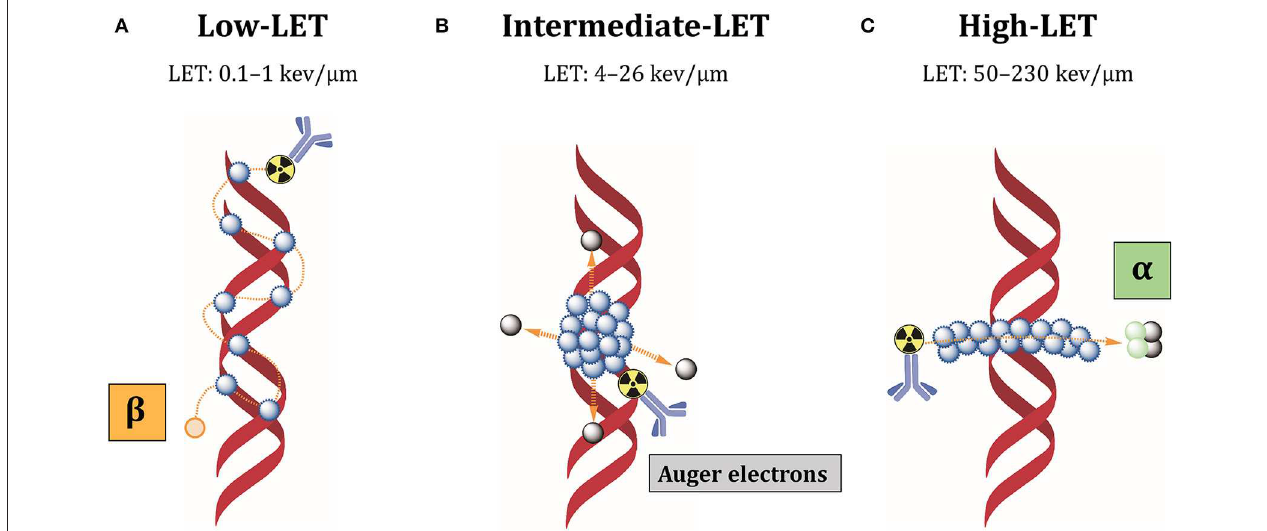
FIGURE 6 | Cellular damages induced by different LET radiations. (A) Low-LET radiations produced by beta-particles induce individual DNA lesions that can be easily repaired by the DNA repair machinery. (B) Auger electrons are released as a cascade close to cell membrane or DNA, producing clusters of lethal DNA lesions. (C) Alpha radiations have high-LET and produce multiple damages along a linear track that are difficult to repair. Blue dots: ionizations/excitations.